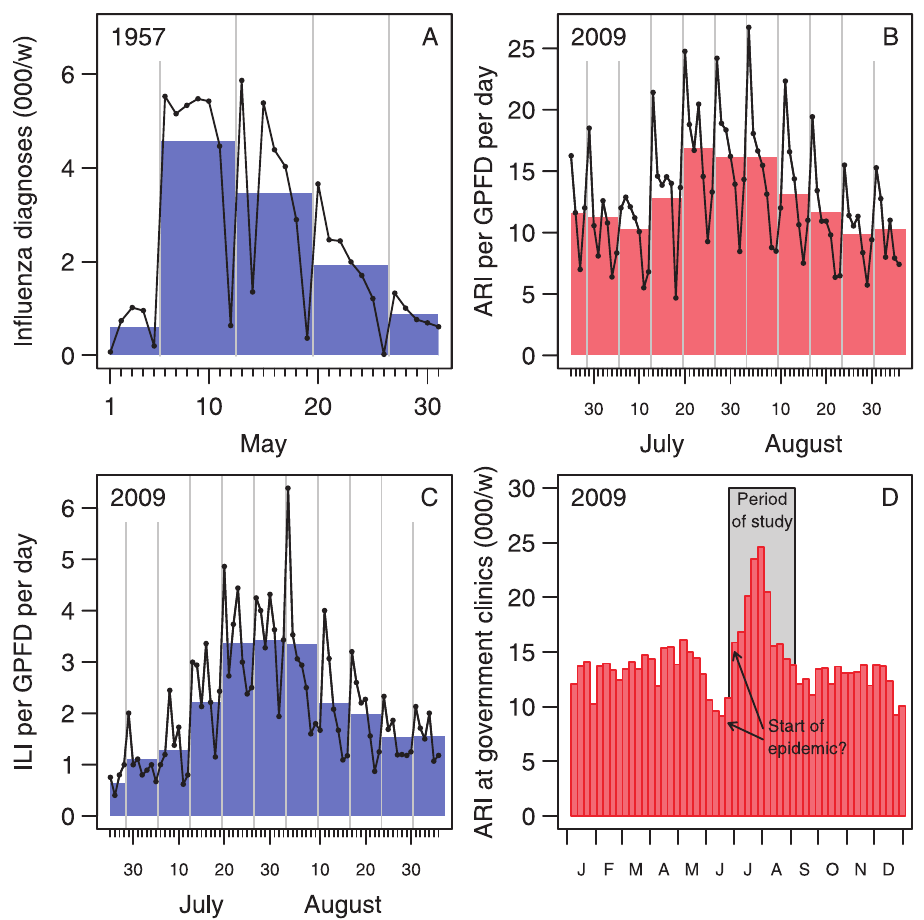
Figure 1. Influenza diagnoses in Singapore in 1957 and 2009 using alternative methods. (A) ILI in government and city council clinics, 1957 [7]. (B) ARI in this GPFD sentinel network, 2009. (C) ILI in this GPFD network, 2009. (D) Weekly ARI in government polyclinics, 2009 [31]. (A–C) Both daily counts (lines) and weekly averages (shaded polygons) are presented. (D) A marked drop in baseline ARI consultations can be seen immediately before the epidemic, complicating the determination of when the epidemic started using this measure.